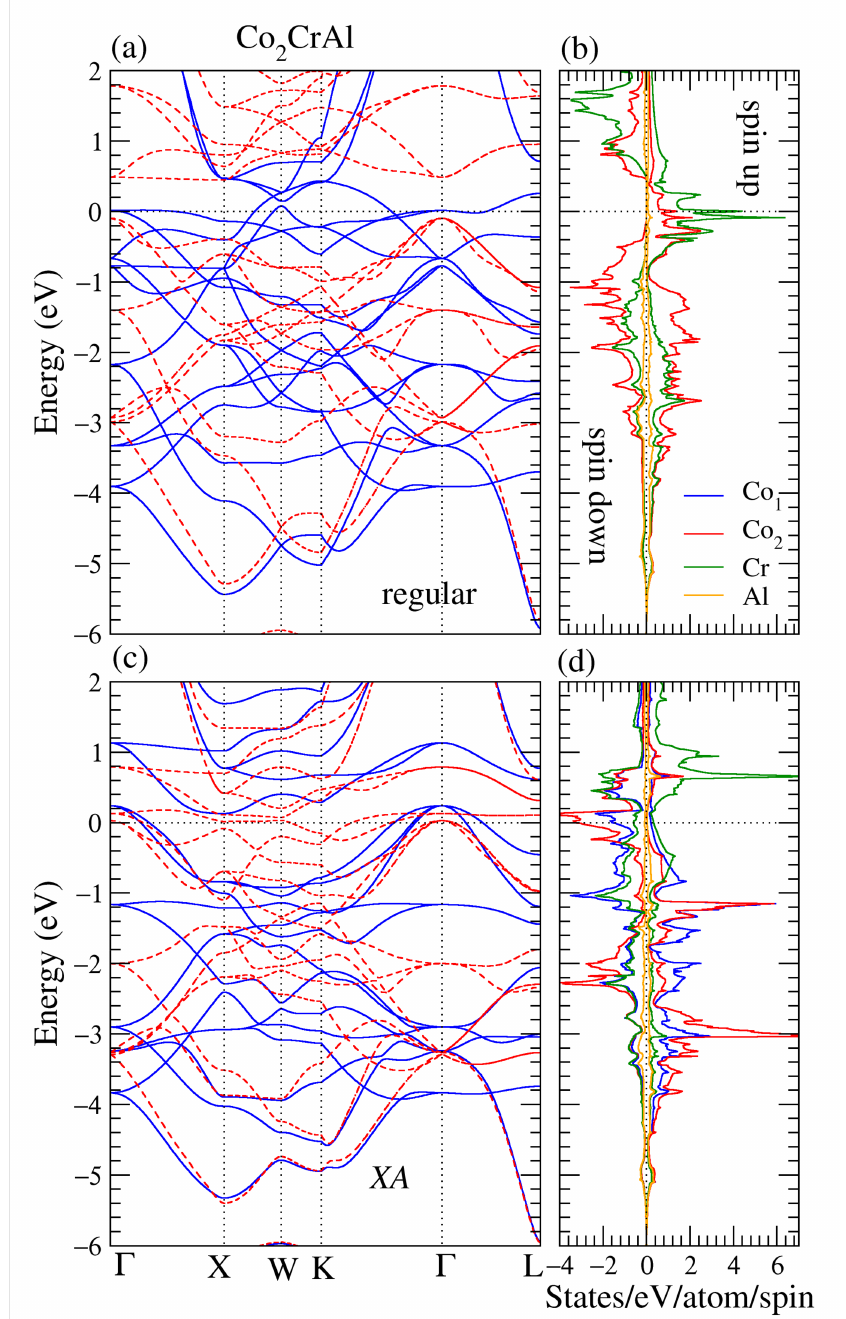
Figure 2. Left panel ( a , c ), scalar relativistic band structures; right panel( b , d ), atom and spin decom- posed density of states for Co 2 CrAl in the regular and XA structures. The solid blue lines in ( a , c ) are for the spin-up bands, and the red-dashed lines are for the spin-down bands. The solid blue, red, green, and orange lines in ( b , d ) are for the two Co, Cr, and Al atoms, respectively.